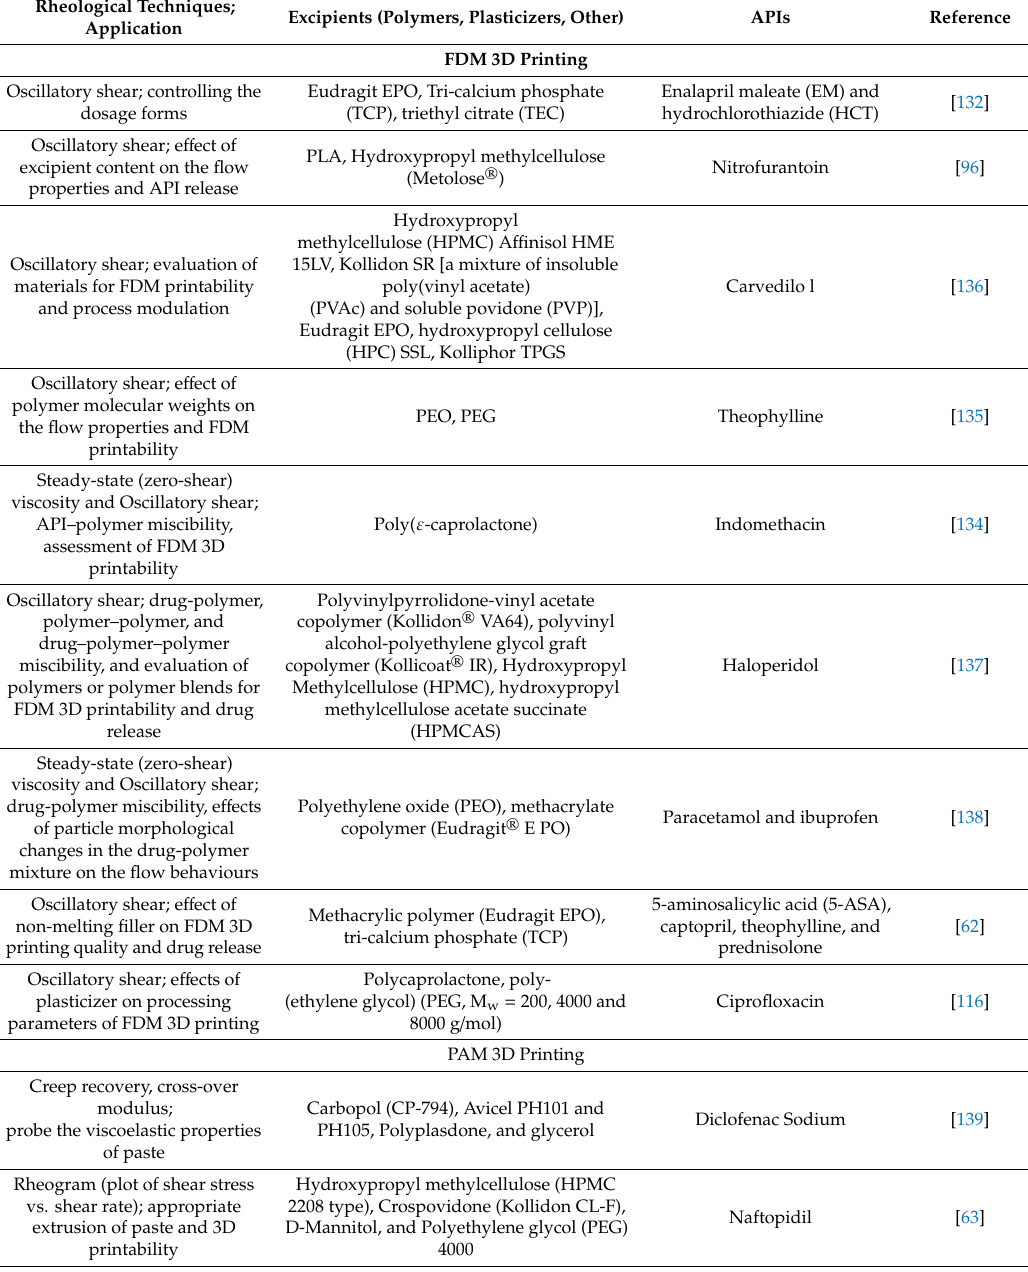
Table 3. Application of rheological techniques for extrusion-based (FDM, PAM) 3D printing and the used API-excipient combinations; literature